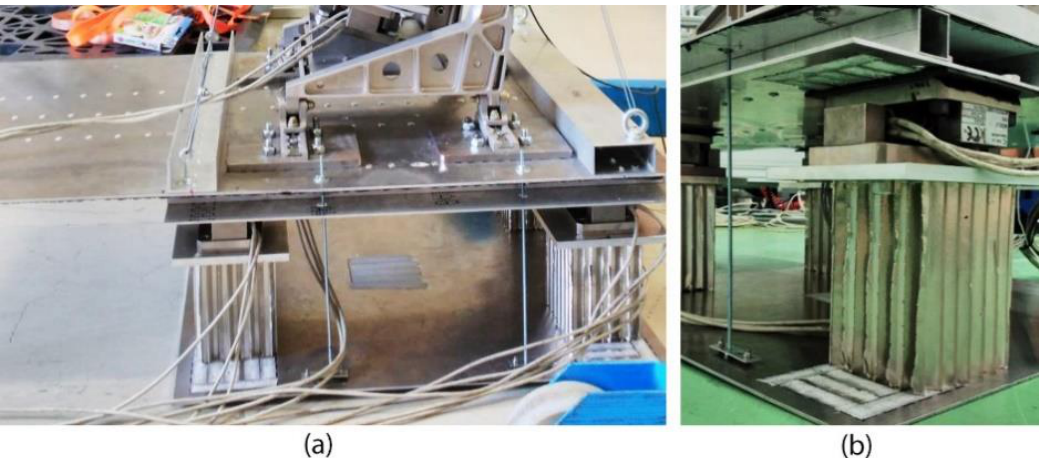
Figure 5. ( a ) Subfloor energy absorbers and ( b ) detail of the load cells mounted between the upper sandwich floor and the energy